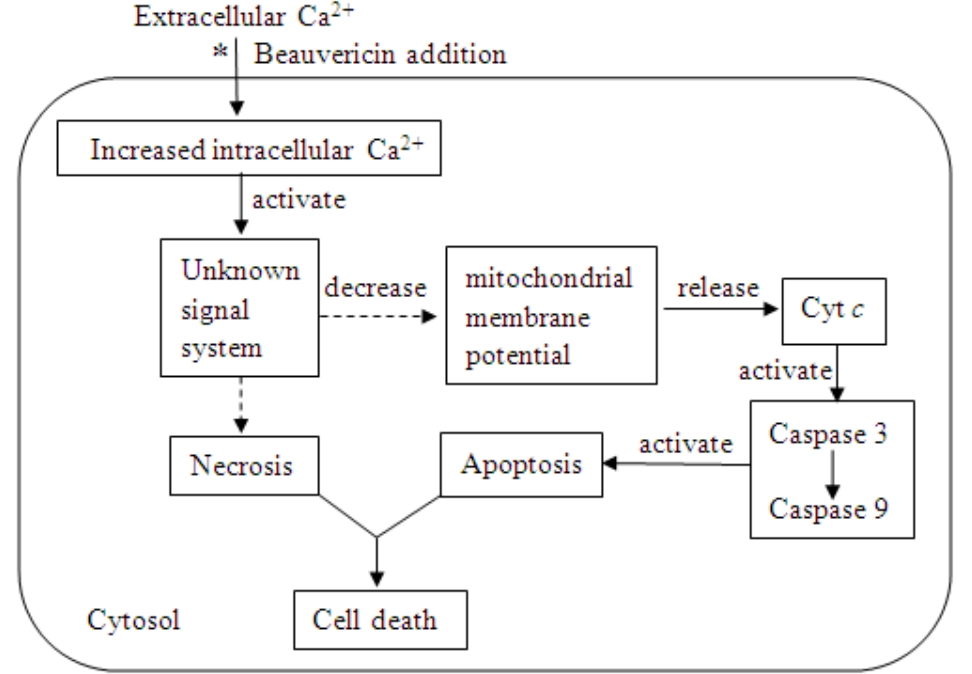
Figure 2. Mechanism of beauvericin cytotoxicity to a human leukemia cell (*beauvericin induced extracellular Ca 2+ movement into the cell resulting in an increase in the level of intracellular Ca 2+ ; dashed arrows indicate the specific mechanisms that are